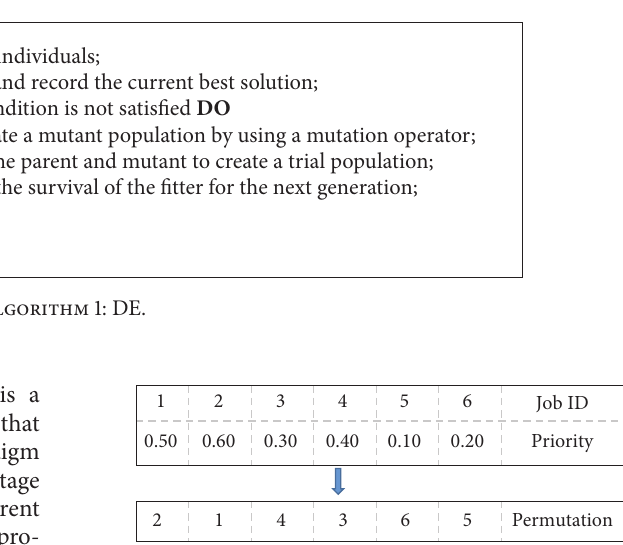
Figure 2: An example for solution representation.